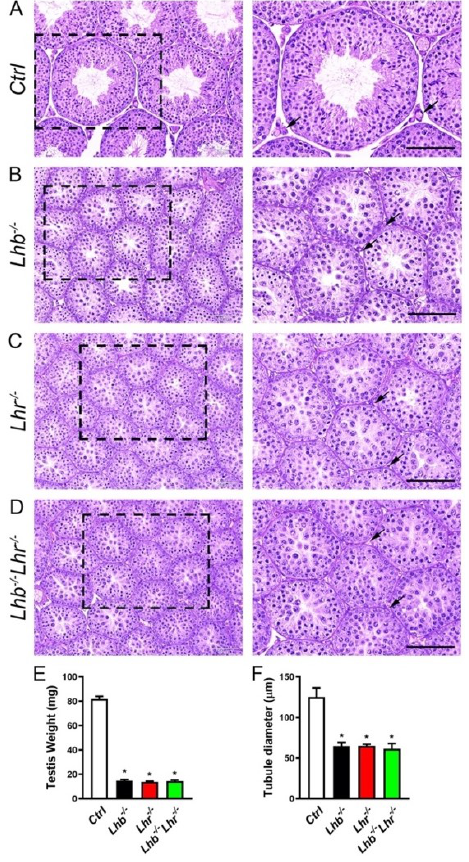
Figure 1. Histo-morphological analysis of testis from single and double null mutant males. PAS- hematoxylin-stained testis sections ( A – D ) indicate that compared to the presence of well-defined interstitium (black arrow in high magnification image of panel ( A )) and all stages of spermatogenesis including late stage spermatids in testis of a control ( Ctrl ) mouse ( A ), the interstitium is poorly developed in single ( Lhb − / − , panel ( B ) and Lhr − / − , panel ( C )) and double mutant ( Lhb − / − Lhr − / − , panel ( D )) mouse testis sections (black arrows in high magnification images of panels ( B – D )).